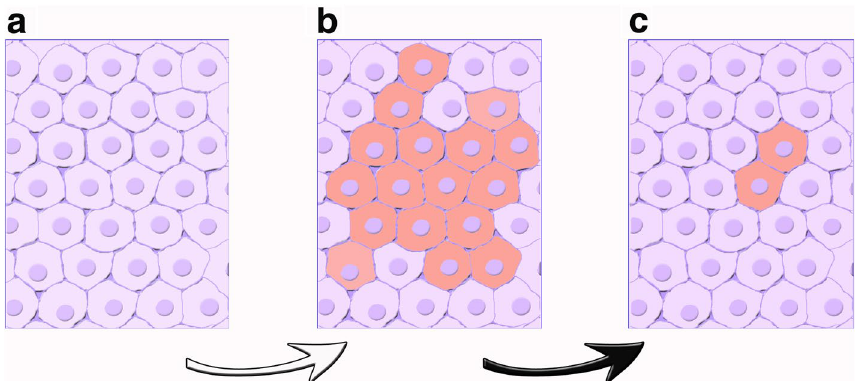
Fig. 3 Role of exosomes in cancer cells. a Normal cells with adequate levels of exosomes, showing no cancer cells. Their growth occurs at normal rate (notshown). b Administration of high levels of exosomes (white arrow) can participate in cancer initiation and progression, dangerous also for the appearance of many other properties. c Administration of cancer growing cells together with exosomes loaded by therapeutic factors (black arrow): for example, adequate antibodies, chemotherapeutic drugs, therapeutic genes or other agents, inducing strong depression of cancer growth. The possible final step is elimination of cancer (not